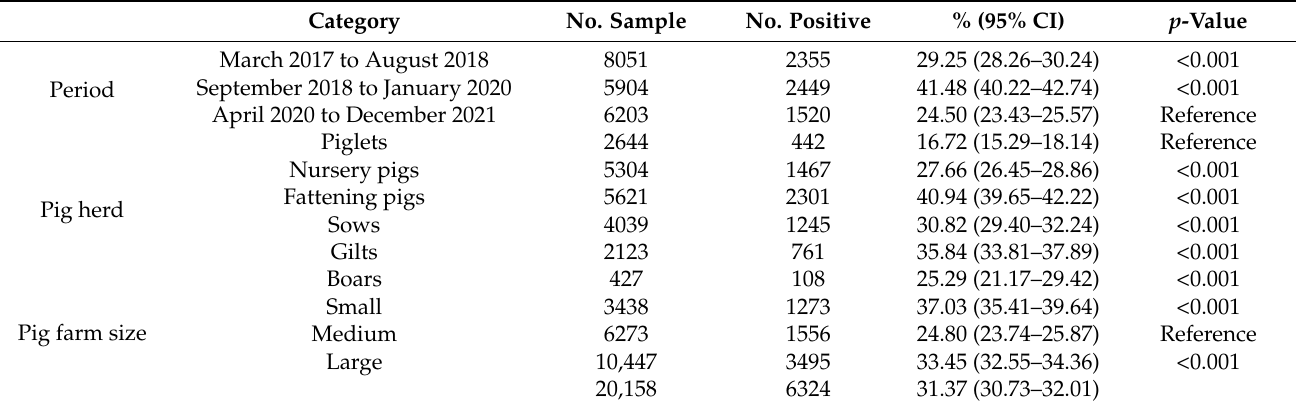
Table 2. Seroprevalence of PRV-gE among pigs in Yunnan province with different risk factors.